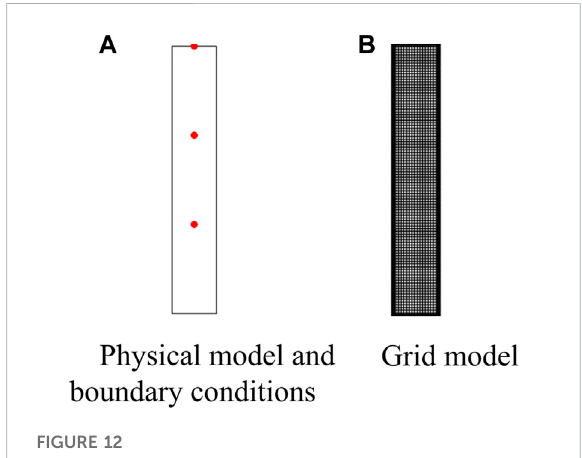
FIGURE 12 Physical model and meshing of the experimental grid.